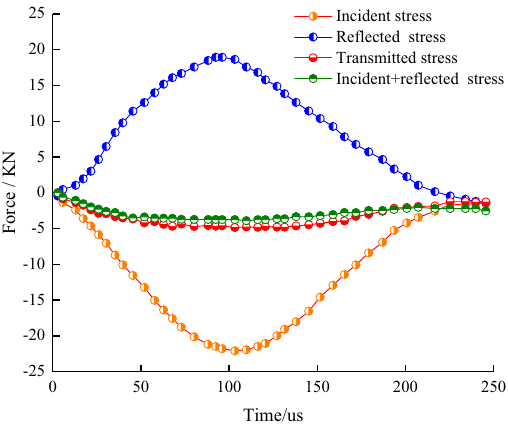
Figure 3. Dynamic stress equilibrium of typical